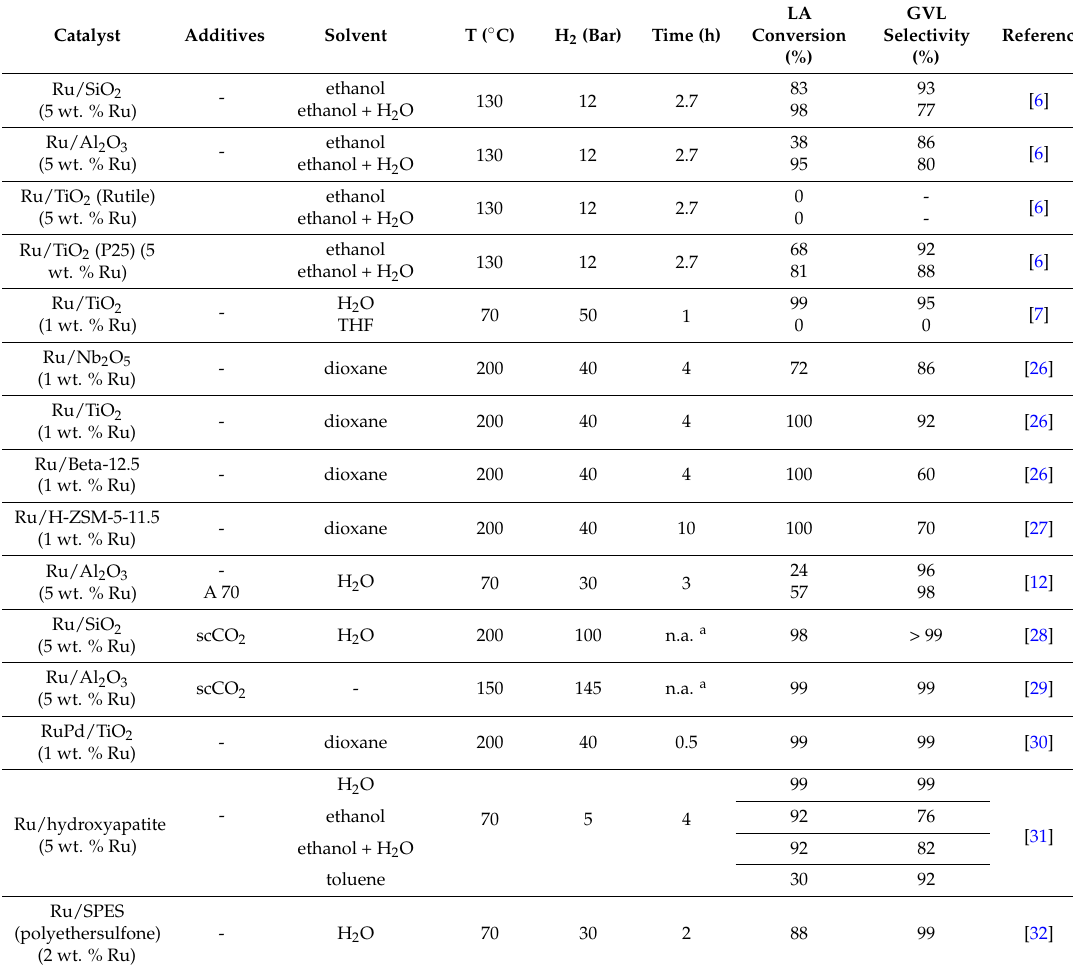
Table 2. Literature overview on LA hydrogenation in batch set-ups using supported ruthenium catalysts (excluding